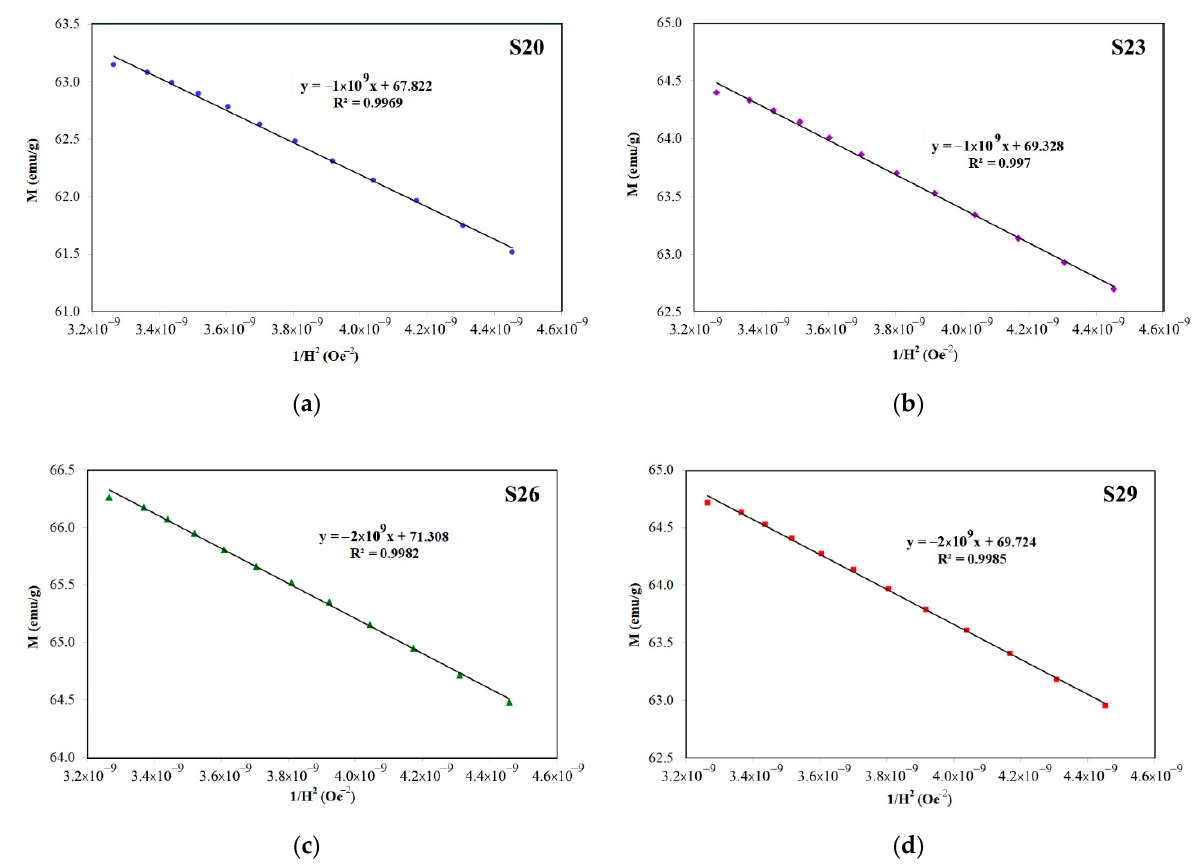
Figure 6. Plots between M and 1/H 2 determining the saturation magnetization of samples ( a ) S20, ( b ) S23, ( c ) S26, and ( d ) S29.